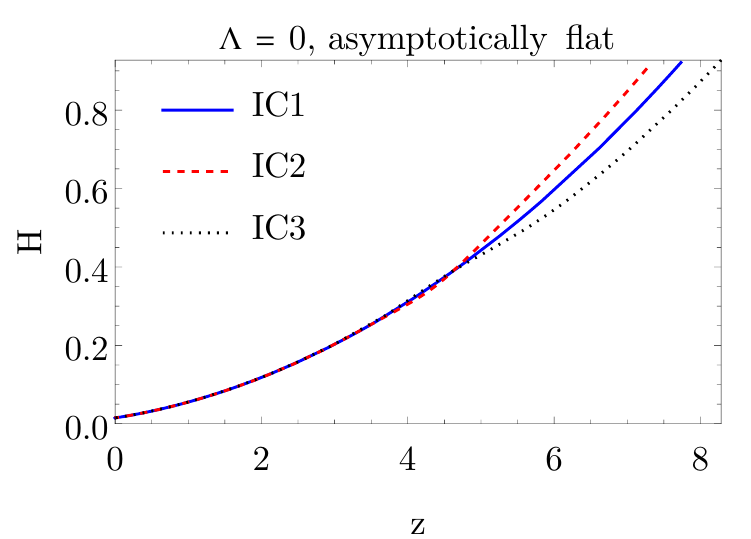
Figure 4 . Evolution of the Hubble rate as function of redshift z for the three different initial conditions presented in figure 3.